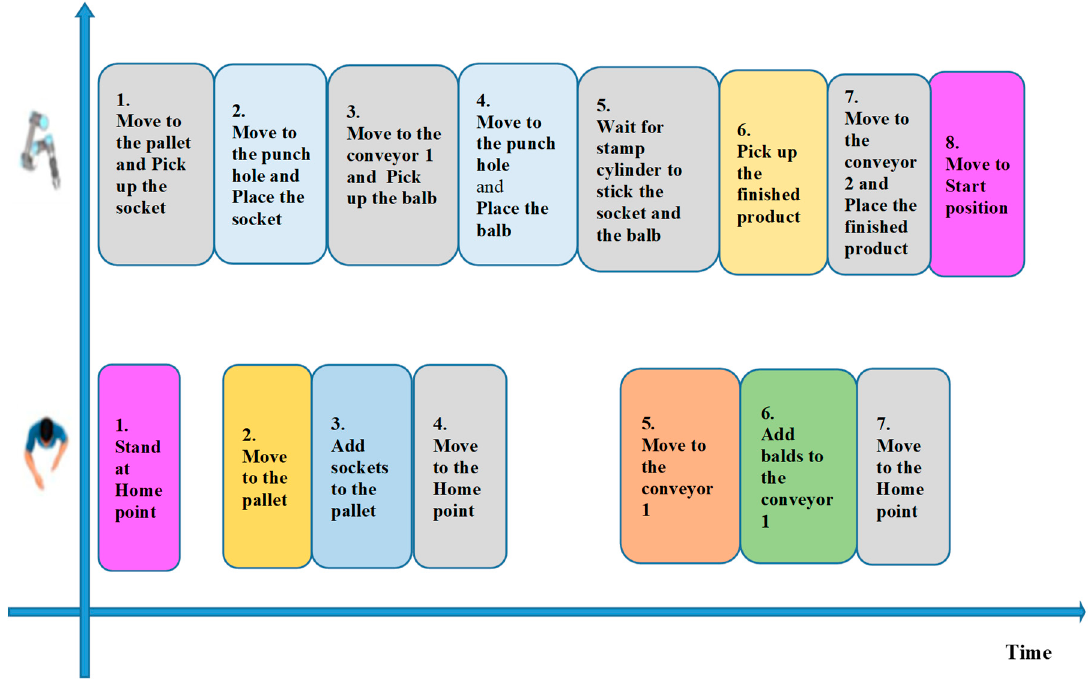
Figure 2. A sequence of tasks performed by humans and robots.